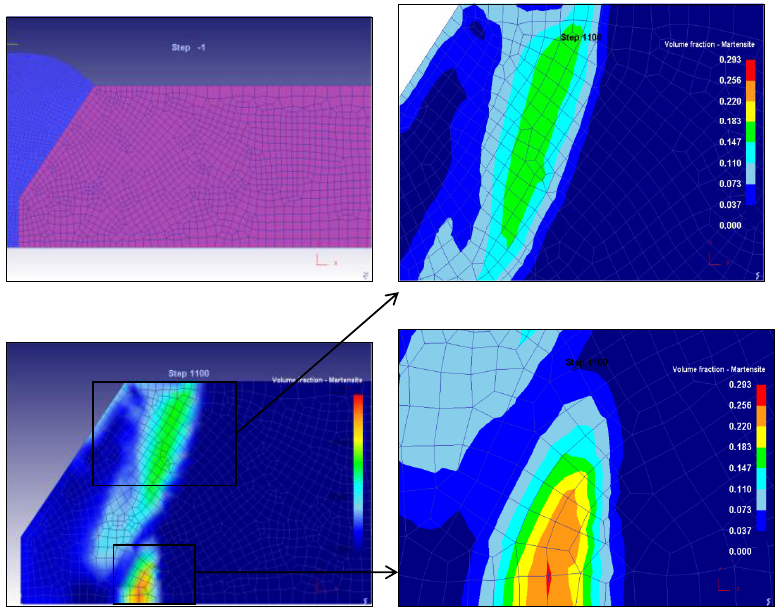
Figure 11. Volume fraction of martensite of HAZ after cooling to room